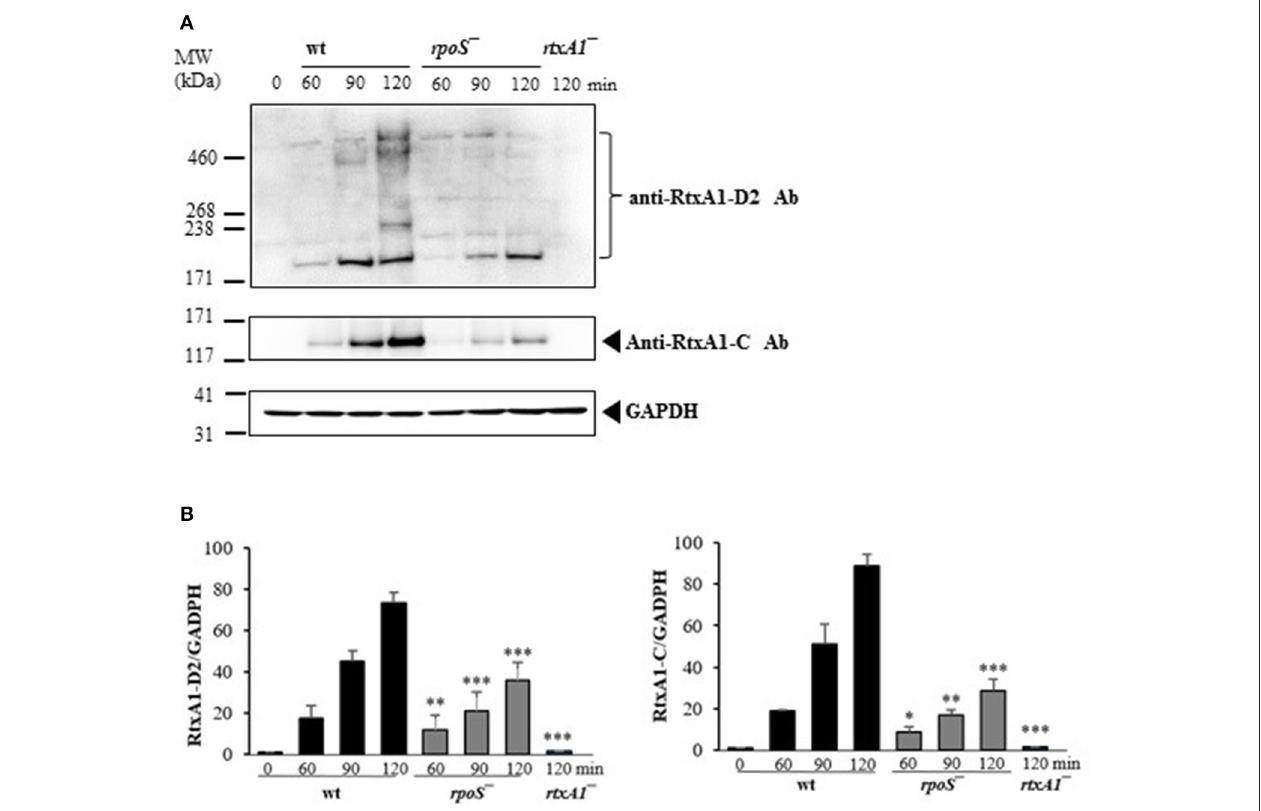
FIGURE 3 | Host contact-induced RtxA1 expression was decreased by an rpoS mutation. (A) HeLa cells were infected with either V. vulnificus wild-type, an rpoS mutant, or rtxA1 mutant strains at an MOI of 20. RtxA1 proteins in the HeLa lysates were detected by Western blot analysis. Two RtxA1 antibodies (Ab) specific to amino acids 1492–1970 (RtxA1-D2 domain) or 4080–4701 (RtxA1-C) were used. GAPDH was used as a loading control of HeLa lysates. The Western botting was conducted three times and the result shown is a representative experiment. (B) Protein levels from three experiments were analyzed and quantified using Image